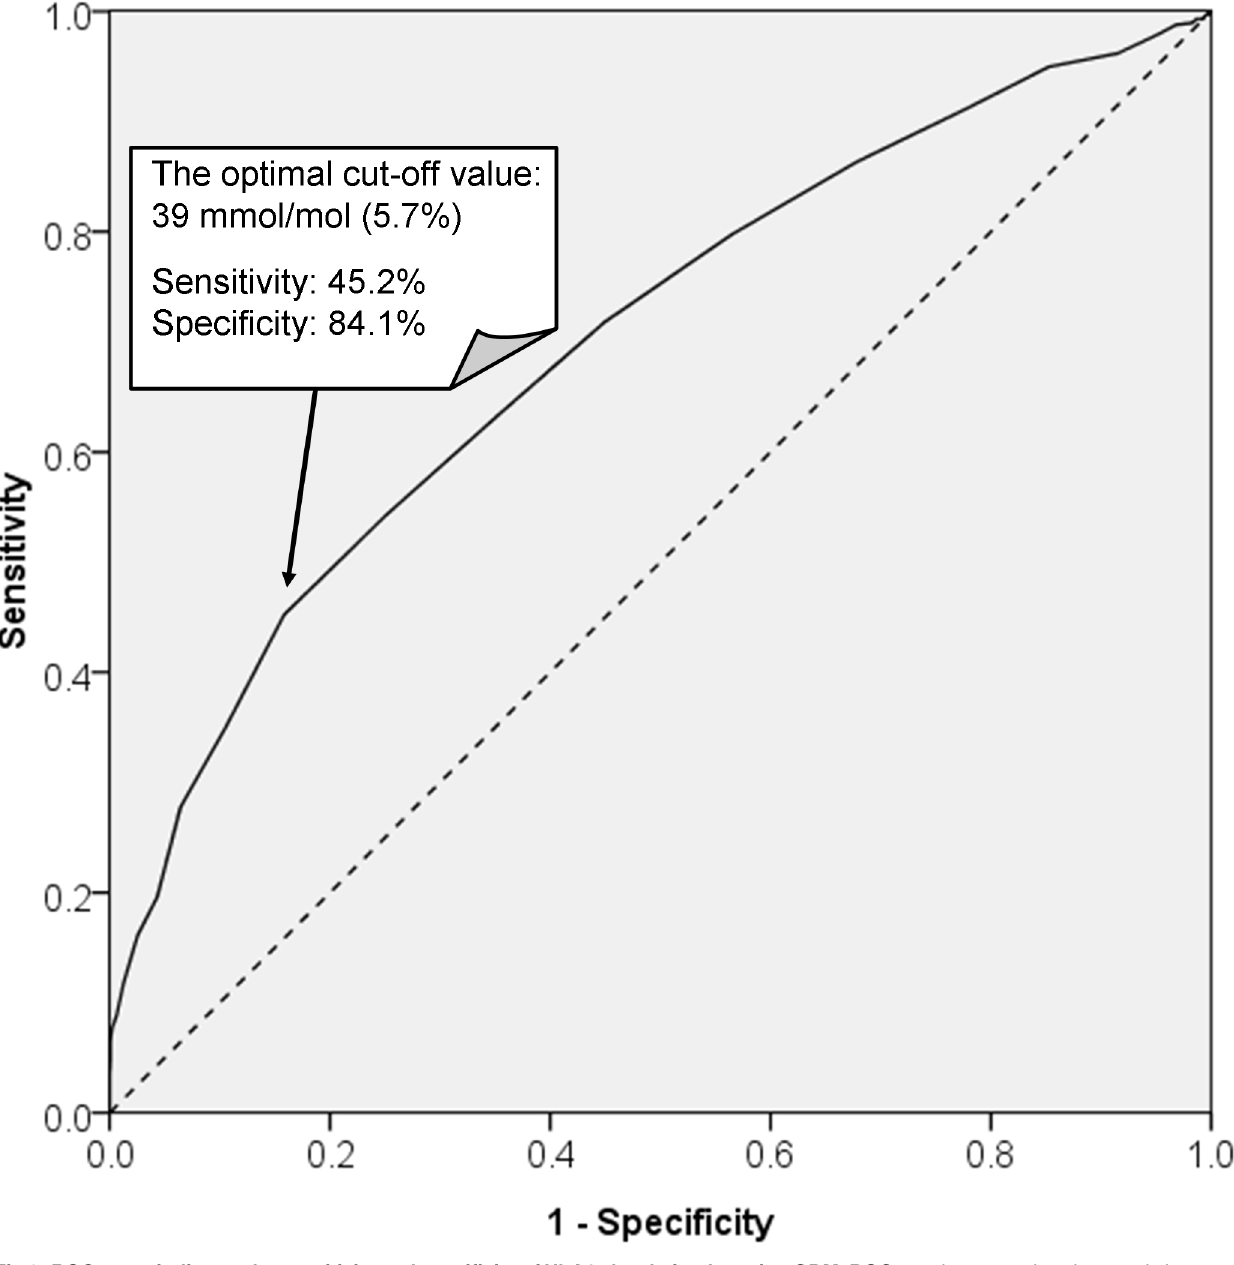
Fig 3. ROC curve indicates the sensitivity and specificity of HbA1c levels for detecting GDM. ROC, receiver operatingcharacteristic; HbA1c, hemoglobinA1c; GDM, gestational diabetes